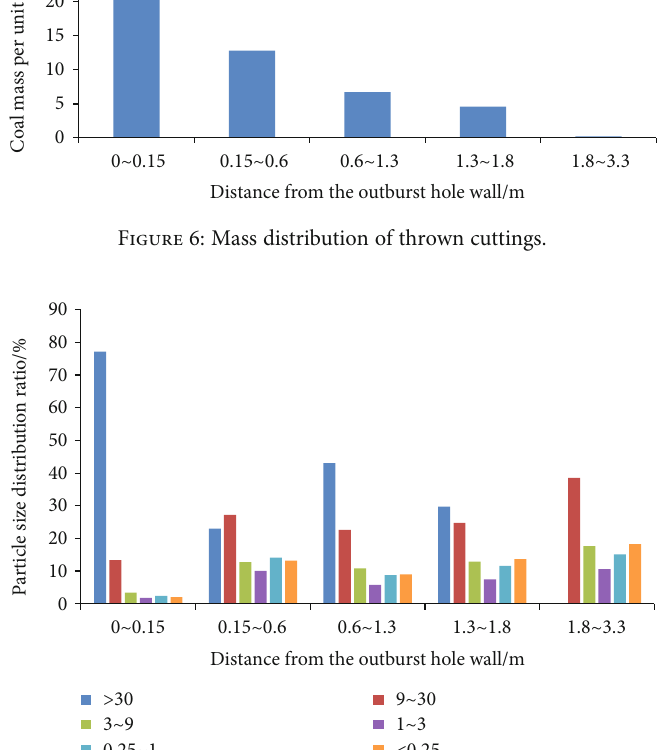
Figure 7: The particle size distribution diagram of thrown cuttings in di ff erent